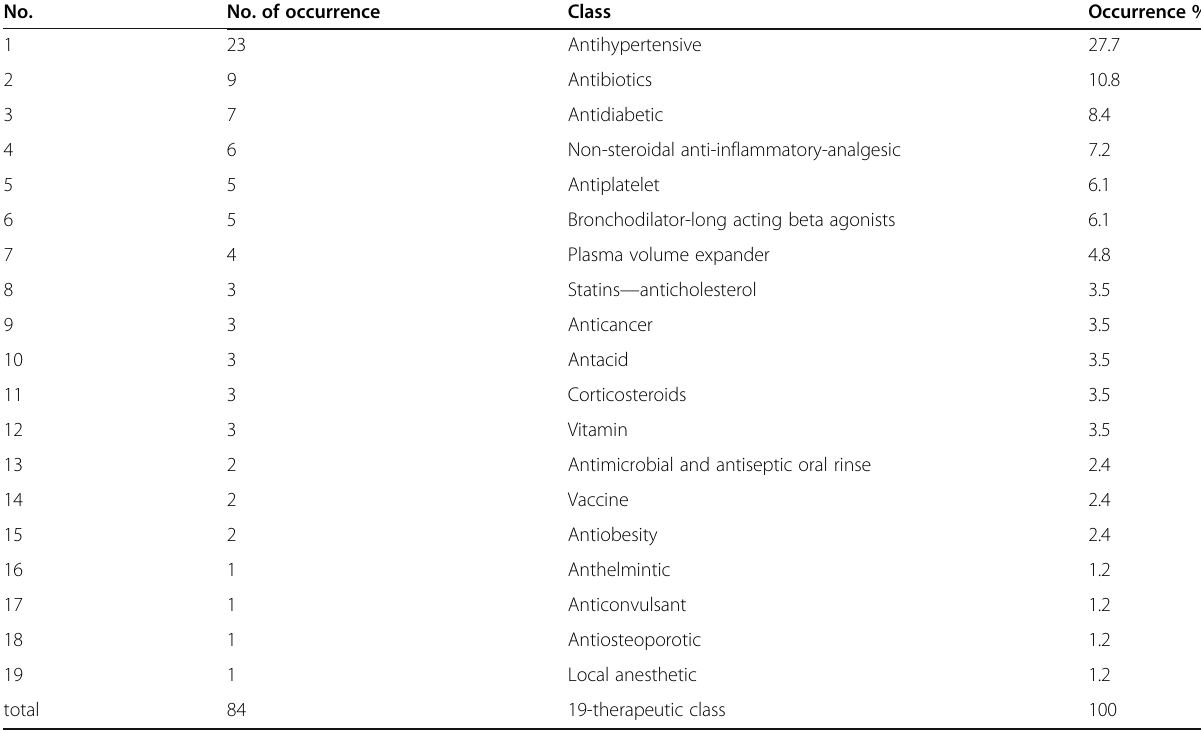
Table 2 Therapeutic class for the drug recall data (2010 – January 2019)